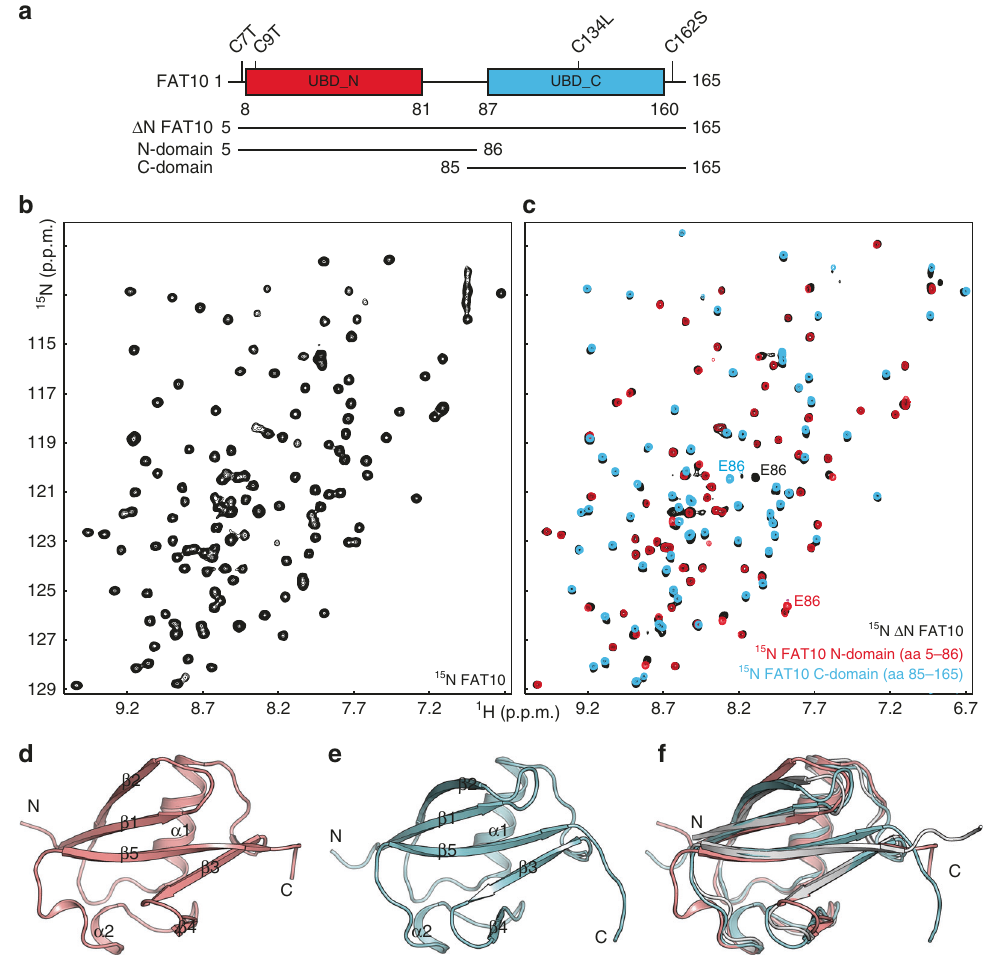
Fig. 1 The two FAT10 UBDs are structurally independent in solution. a Schematic representation of the FAT10 NMR constructs and domain boundaries. Ubiquitin-like domain (UBD)_N and UBD_C denote the boundaries of the N- and C-terminal ubiquitin-like (UBL) folds, respectively. b Representative region of the 1 H, 15 N-correlation spectrum of Cys-free full-length human FAT10 (FAT10 C0) and c an overlay of the 1 H, 15 N-correlation spectra of the Cys-free FAT10 lacking the N-terminal four amino acids ( Δ N FAT10) with the isolated Cys-free FAT10 N- (red) and C- (cyan) domains, respectively. Except for E86 at the C-terminus of the N-domain and the N-terminus of the C-domain, the spectra of the isolated domains are highly similar to the Δ N FAT10 construct demonstrating the structural independence of the domains. d Ribbon representation of the crystal structure of the FAT10 N-domain. Secondary structure elements are labeled to highlight the canonical ββαββαβ β -grasp fold. e Ribbon representation of the lowest energy NMR structure of the FAT10 C-domain. f Overlay of the structures of the FAT10 N- and C-domain (salmon and cyan, respectively) with Ub (PDB ID: 1UBQ) (gray). The structures superimpose with Ub with an r.m.s.d. for all backbone atoms of 0.764 Å for the N-domain (amino acids 8 – 81) and 0.964 Å for the C-domain (amino acids 88 –